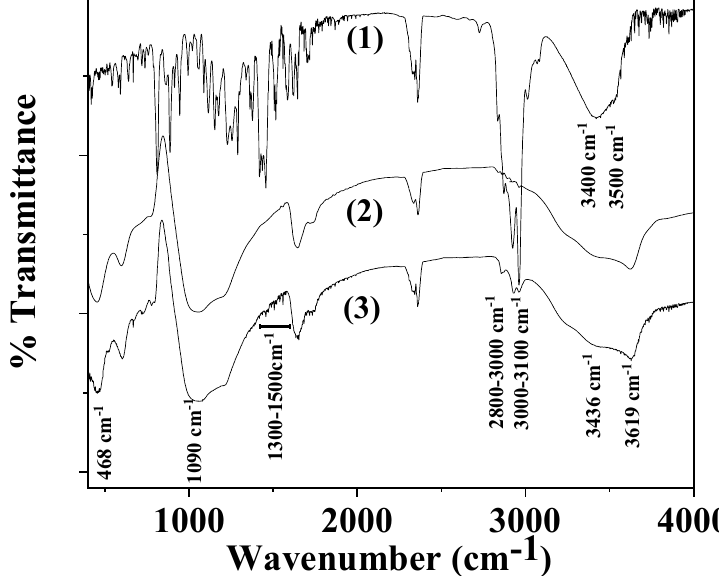
Figure 4. FTIR plots of: (1) TO as received, (2) NZ as received, (3) modified TO@NZ hybrid nanostructure.